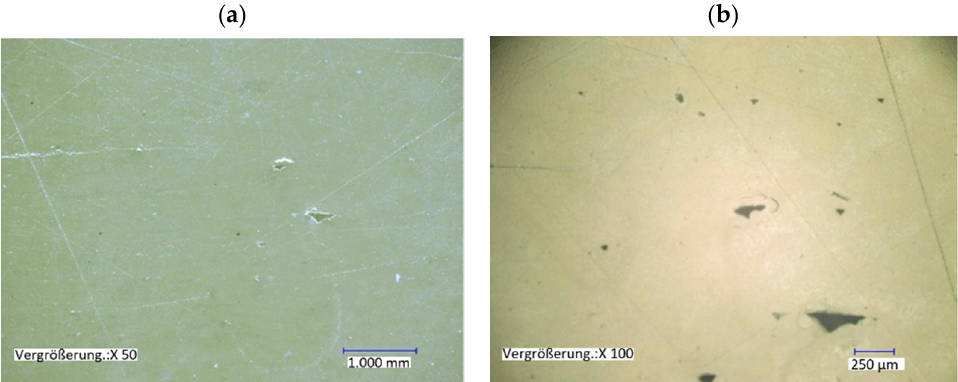
Figure 9. Micrographs of 3D-printed tensile test bars in the Y-direction, ( a ) wall section of the tensile test bar, ( b ) Detail view of the porosity found.